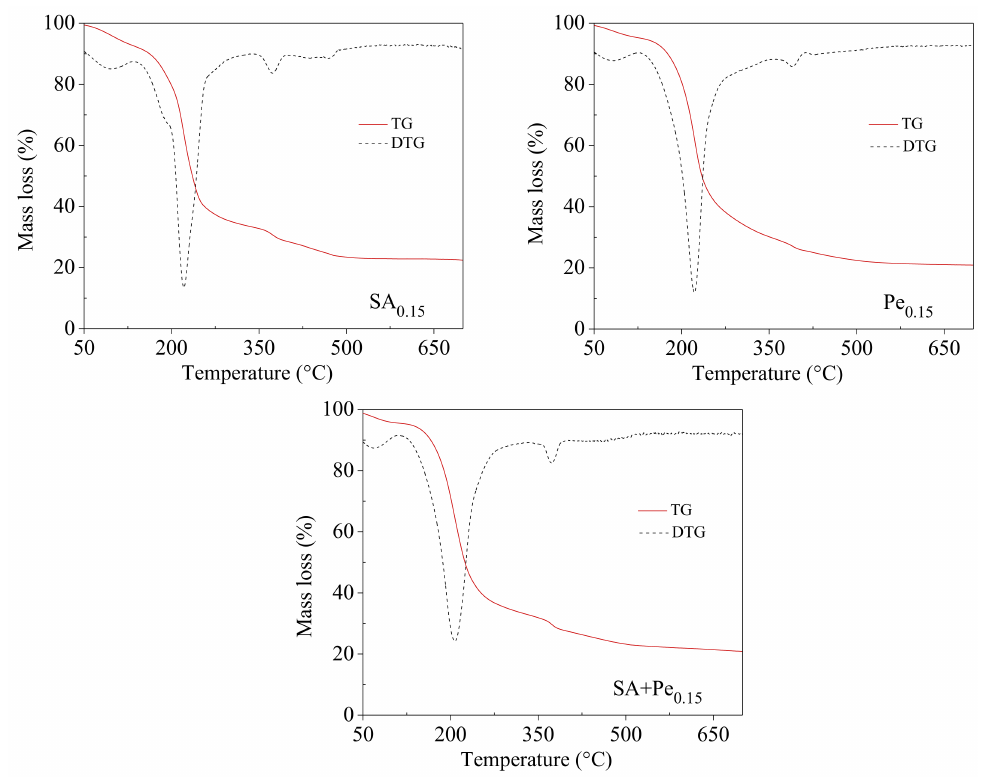
Figure 2. Thermogravimetric curves of SA 0.15 , Pe 0.15 and SA + Pe 0.15 under N 2